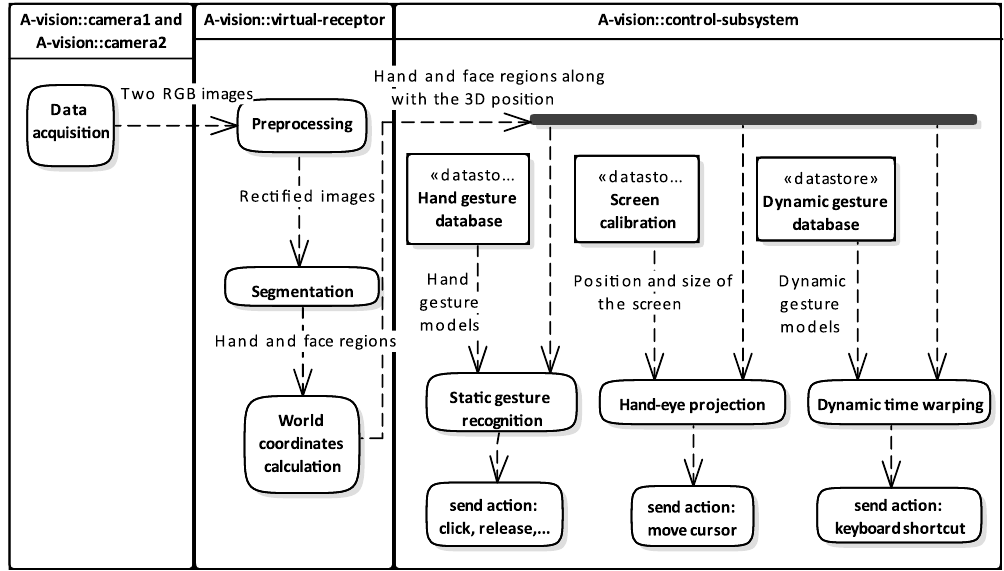
Figure 25. Processing flow in the vision agent a vision